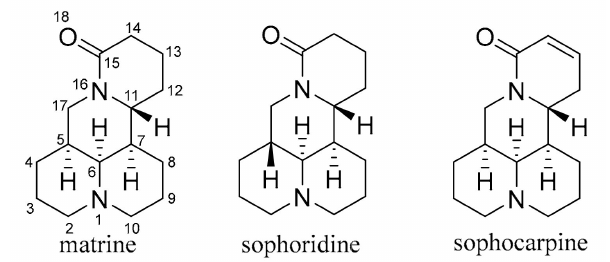
Figure 1. Structures of matrine, sophoridine, and sophocarpine.